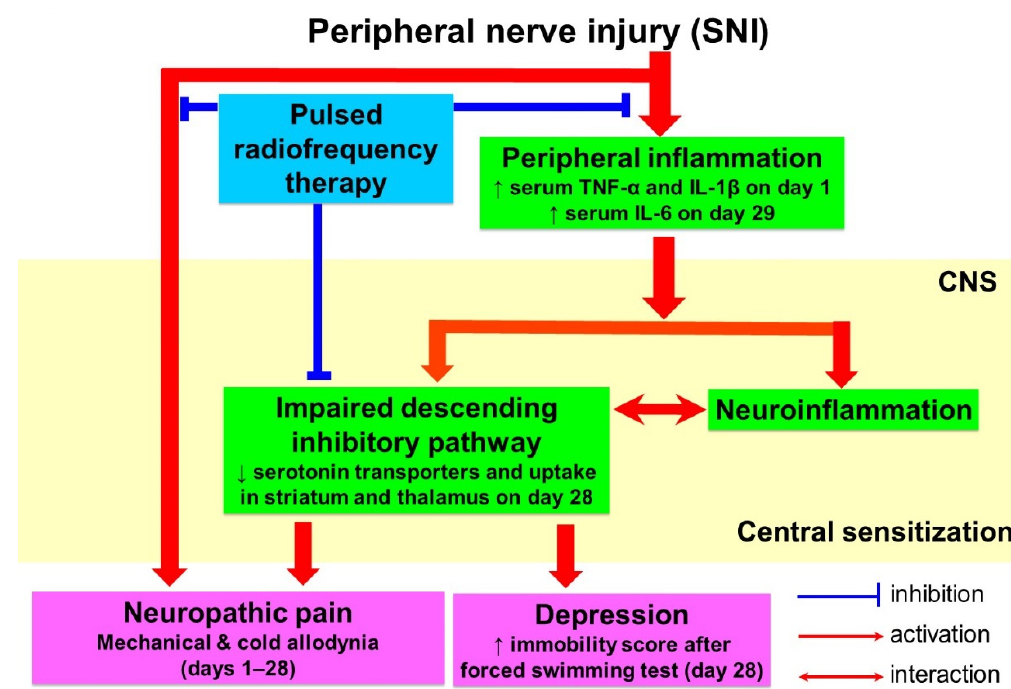
Figure 6. Proposed mechanism of PRF on SNI-induced neuropathic pain and depression-like be- havior in